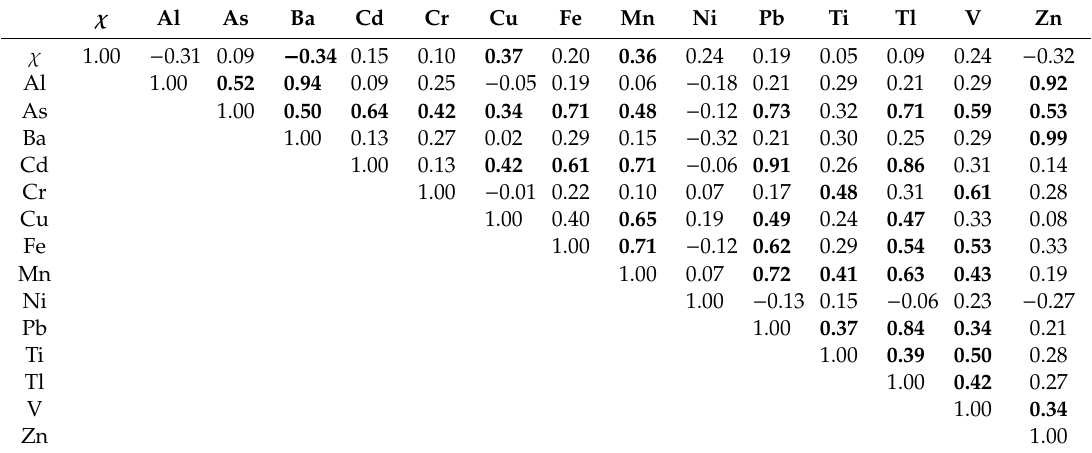
Table 6. Spearman’s rank correlation matrix for PM1 ( n = 35).